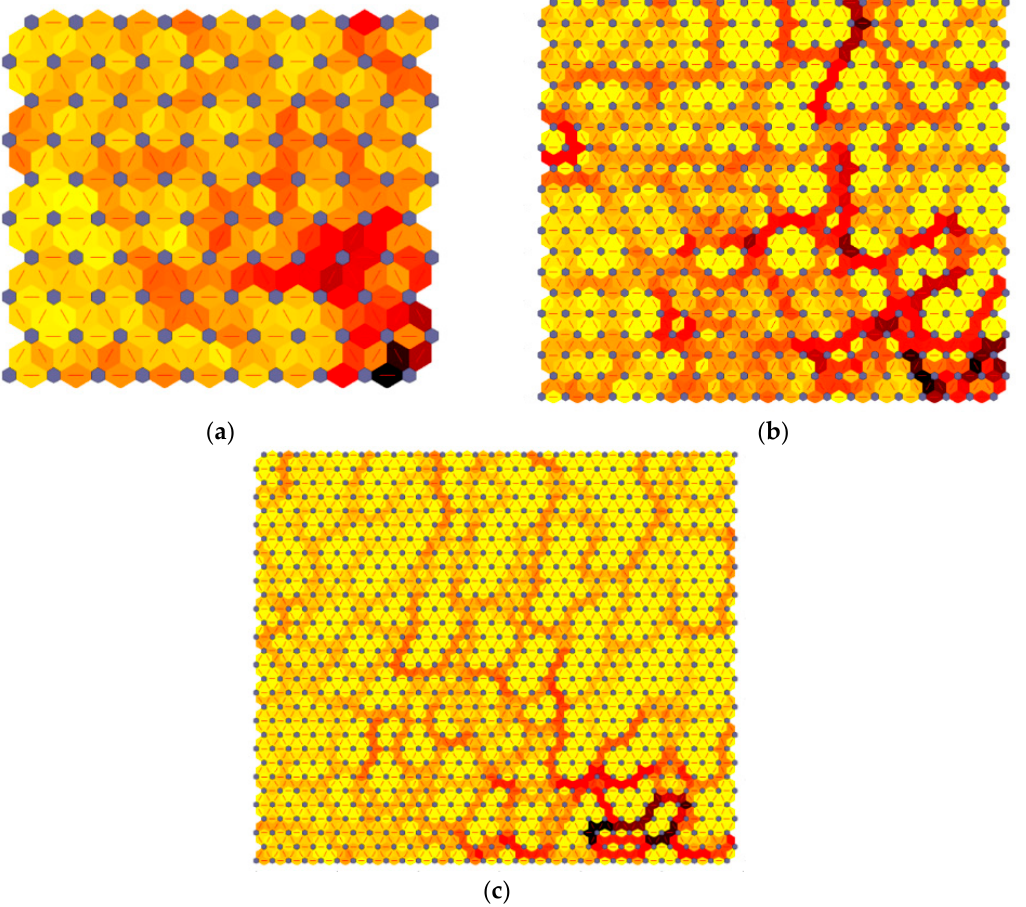
Figure 5. Self-organizing map of neighbor weight distances for the three evaluated scenarios: ( a ) Type-1 with 100 neurons and 13 groups, ( b ) Type-2 with 400 neurons and 47 groups, and ( c ) Type-3 with 900 neurons and 56 groups.